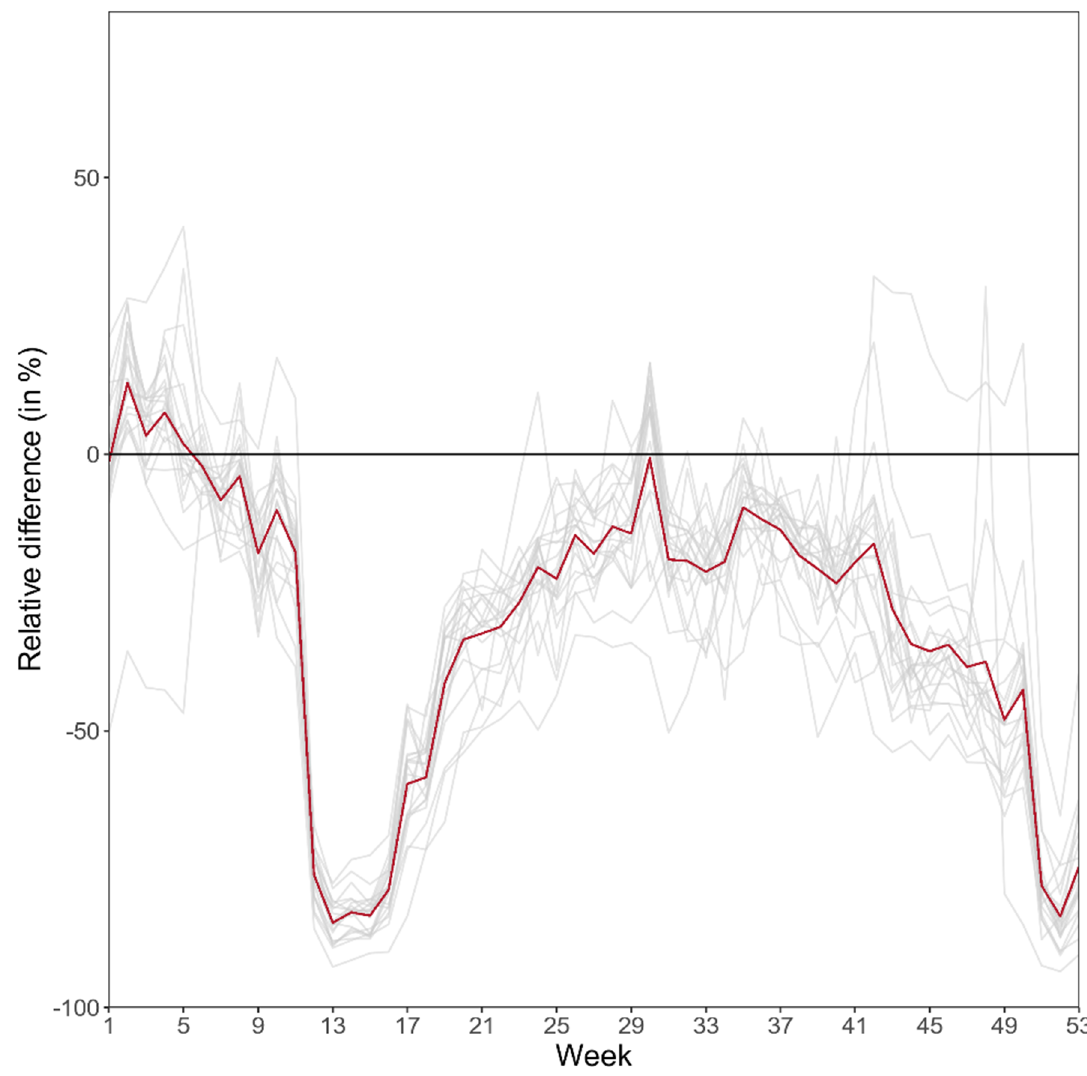
Grey lines show weekly relative difference per city, the red line shows the weekly average overall cities, and the black solid horizontal line indicates a zero